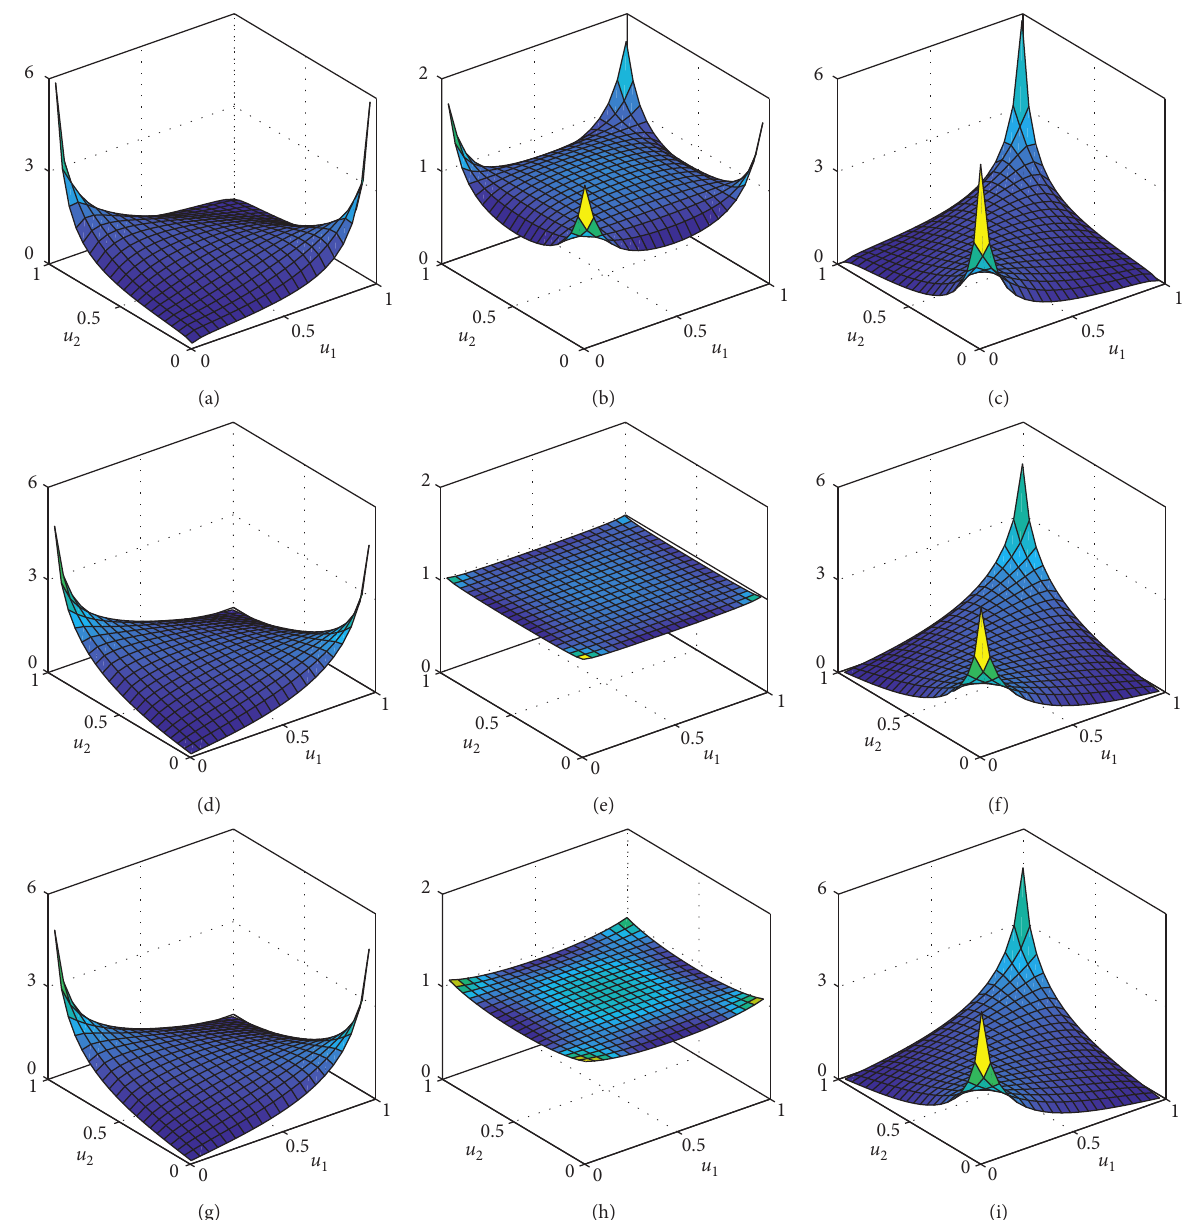
Figure 1: The bivariate NCCN copula density function. (a) ρ �− 0.5, a � 0.5, and p � 0.5. (b) ρ � 0.5, a � 0.5, and p � 0.5. (c) ρ � 0.5, a � 0.5, and p � 0.5. (d) ρ �− 0.5, a � 0.9, and p � 0.5. (e) ρ � 0, a � 0.9, and p � 0.5. (f) ρ � 0.5, a � 0.9, and p � 0.5. (g) ρ �− 0.5, a � 0.5, and p � 0.9. (h) ρ � 0, a � 0.5, and p � 0.9. (i) ρ � 0.5, a � 0.5, and p �